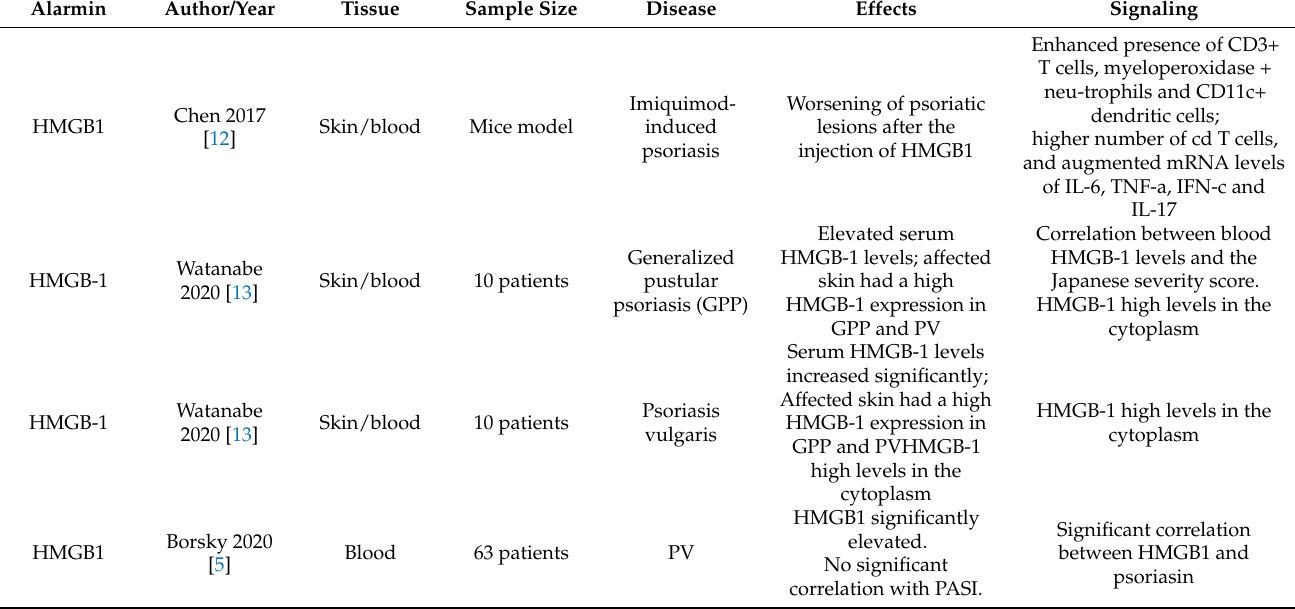
Table 1. HMGB1 serum and tissue concentration and effects in the different types of